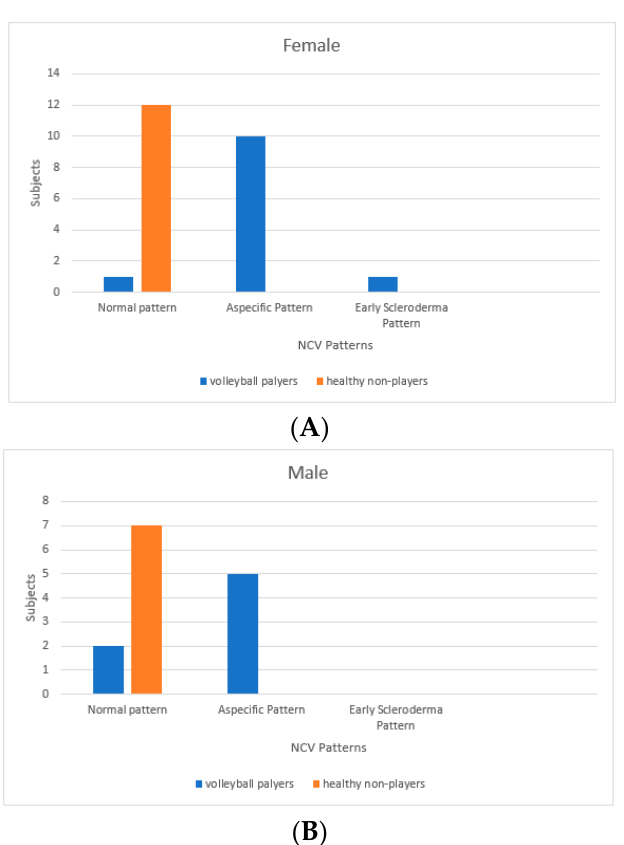
Figure 1. ( A ) Female subjects divided by nailfold video-capillaroscopic (NVC)patterns; ( B ) Male subjects divided by nailfold video-capillaroscopic (NVC) patterns.